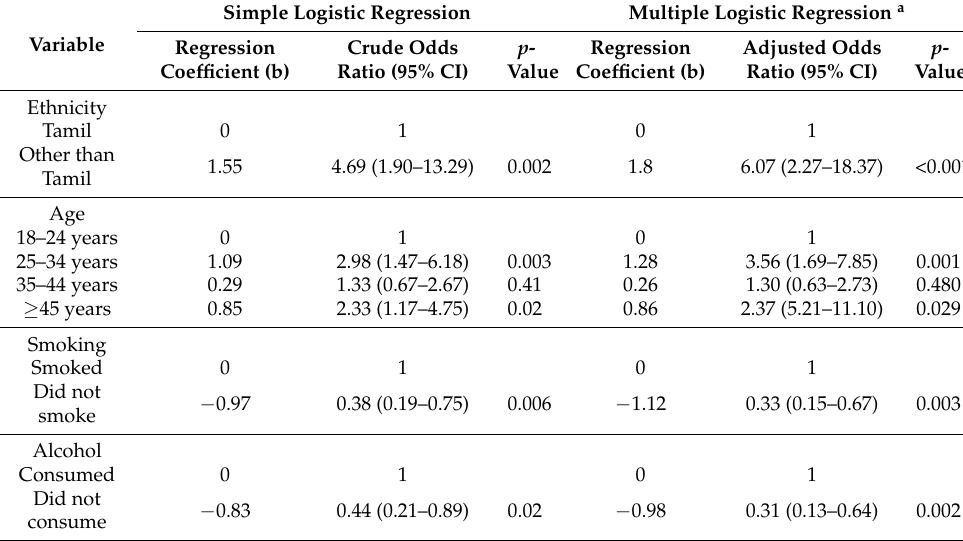
Table 5. Demographic and habitual factors of periodontal disease among adult population in Tamil Nadu, India, 2021 by using simple and multiple logistic regression analyses ( n =